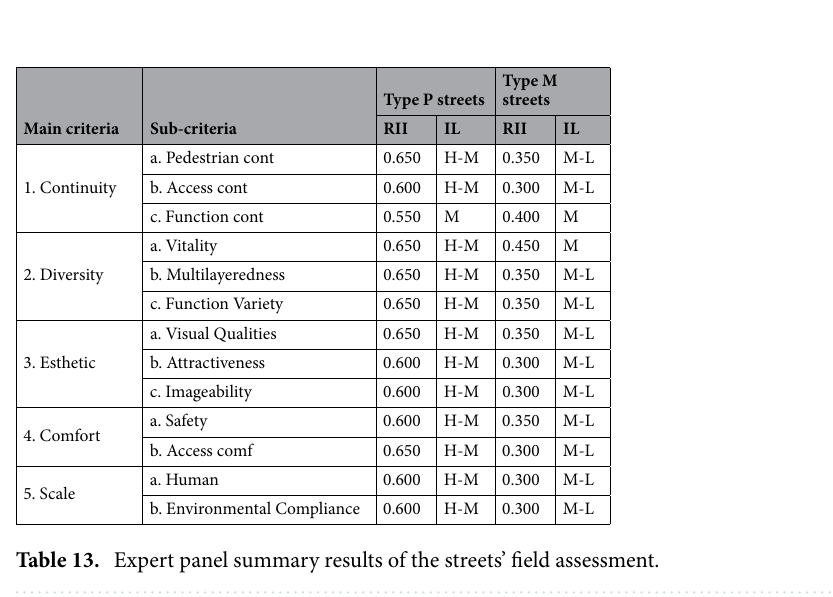
Table 13. Expert panel summary results of the streets’ field assessment.